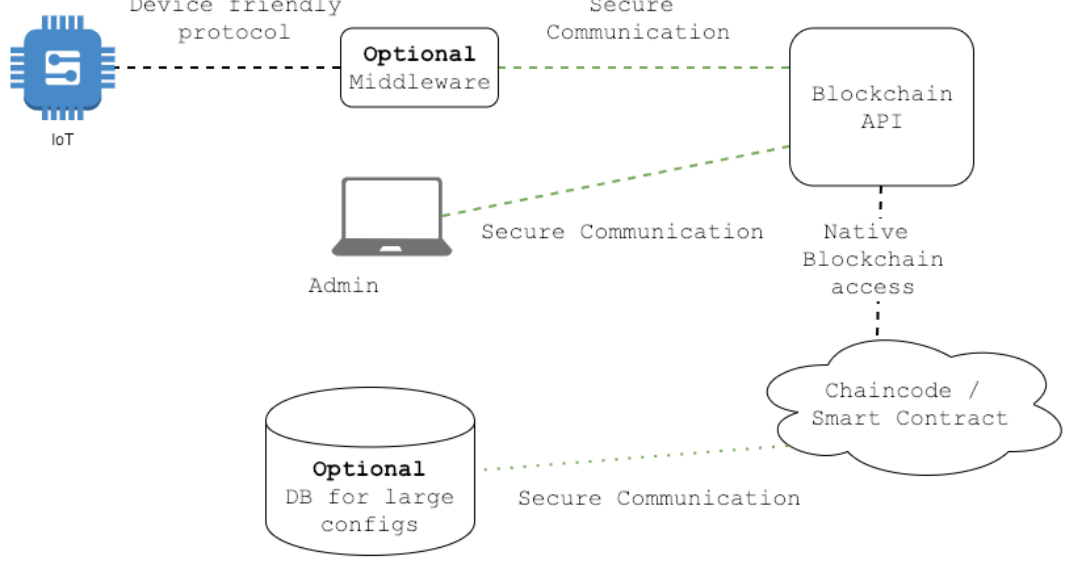
Figure 3. Improved Figure 3. Improved architecture.